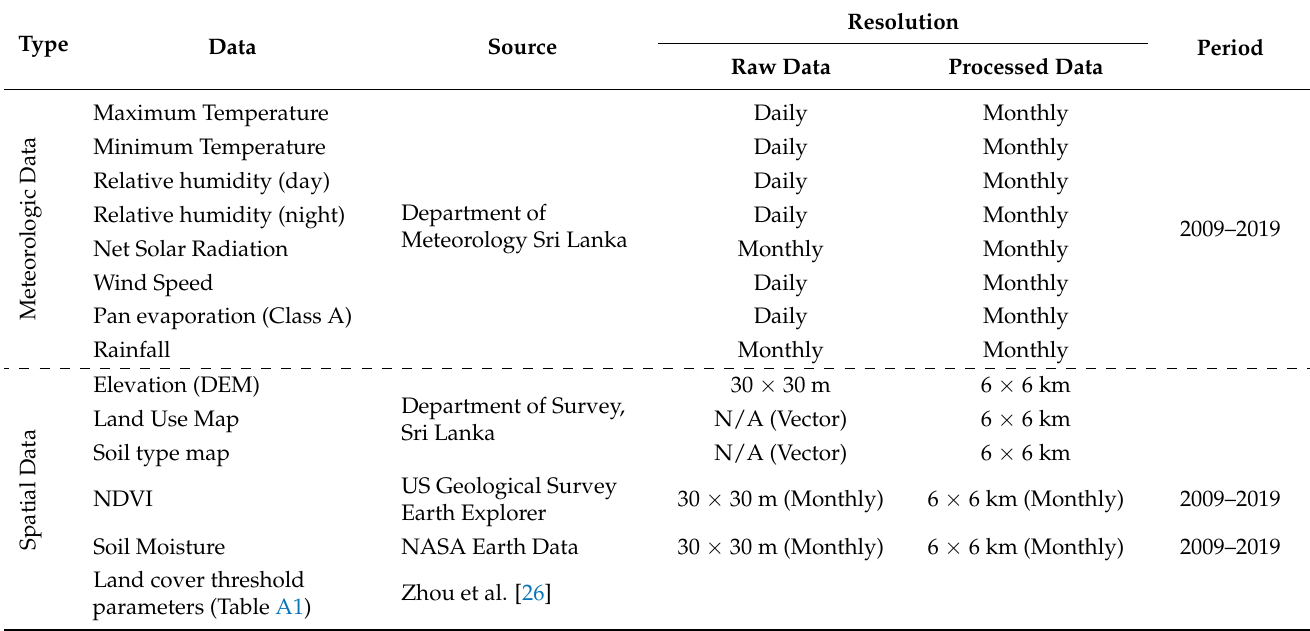
Table 1. Summary of data including data types, sources, resolutions and